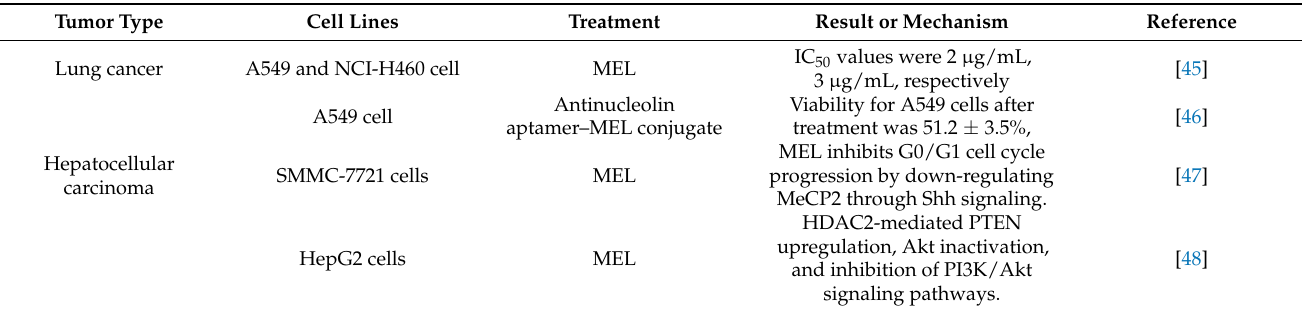
Table 2. Anti-tumor effects of